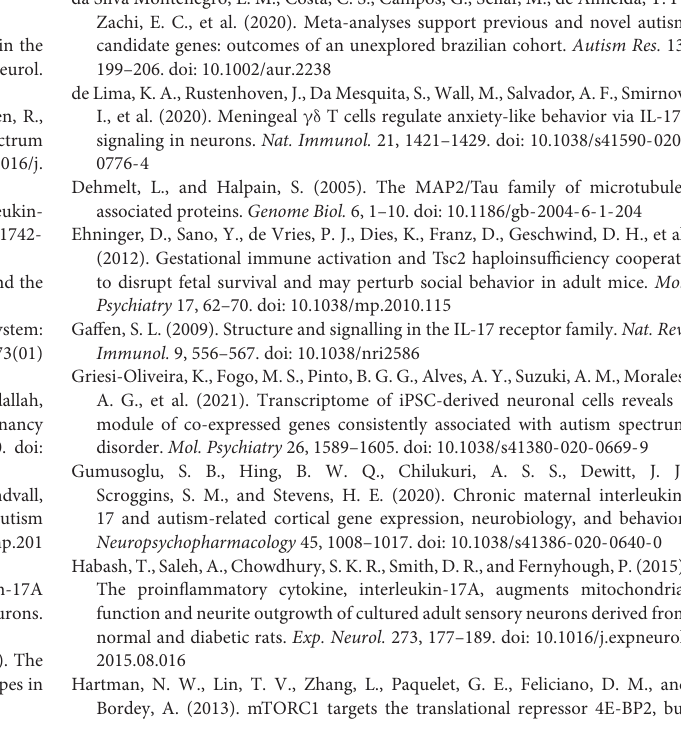
Supplementary Figure 1 | Original western blot images used in this study. (A) Original images of western blots showing expression levels of IL17RA in iPSC-derived NPCs of control (C; n = 5) and ASD (P; n = 7) subjects. β -actin was used as a loading control. (B) Original images of western blots showing expression levels of IL17RA in iPSC-derived NPCs of control (C; n = 2–3) and ASD (P; n = 5) subjects after treatment with either vehicle ( − ) or rhIL-17a (10 and 50 ng/ml) for 48 h. β -actin was used as a loading control. (C) Original images of western blots showing expression levels of pERK1/2 in iPSC-derived NPCs of control (C; n = 4) and ASD (P; n = 6) subjects after treatment with either vehicle ( − ) or rhIL-17a (50 ng/ml). Total-ERK was used as a loading control. (D) Original images of western blots showing expression levels of pRPS6 in iPSC-derived NPCs of control (C; n = 3) and ASD (P; n = 4) subjects after treatment with either vehicle ( − ) or rhIL-17a (50 ng/ml). β -actin was used as a loading control. (E) Original images of western blots showing expression levels of pNF-kB65 in iPSC-derived astrocytes (used as positive control of pNF-kB expression) and in iPSC-derived NPCs of control (C; n = 2) and ASD (P; n = 1) subjects after treatment with either vehicle ( − ) or rhIL-17a (50 ng/ml). Total-NF-kB and β -actin were used as a loading controls. (F–M) Original images of western blots showing expression levels of markers for NPCs (SOX2 and Nestin), neurons (Synaptophysin-1, Synapsin-1, TUJ1, Homer-1 and MAP2) and astrocytes (GFAP) in iPSC-derived neurons of control (C; n = 3–4) and ASD (P; n = 3–6) subjects differentiated in the presence of either vehicle ( − ) or rhIL-17a (10 ng/ml) for 14 day. β -actin was used as a loading control. (N–R) Original images of western blots showing expression levels of markers for NPCs (SOX2), neurons (Synapsin-1, TUJ1, and MAP2) and astrocytes (GFAP) in iPSC-derived neurons of control (C; n = 3–5) and ASD (P; n = 3) subjects differentiated in the presence of either vehicle ( − ) or rhIL-17a (50 ng/ml) for 21 day. β -actin was used as a loading